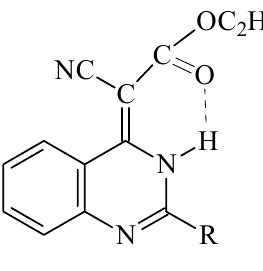
Figure 5. Intramolecular hydrogen bond formation